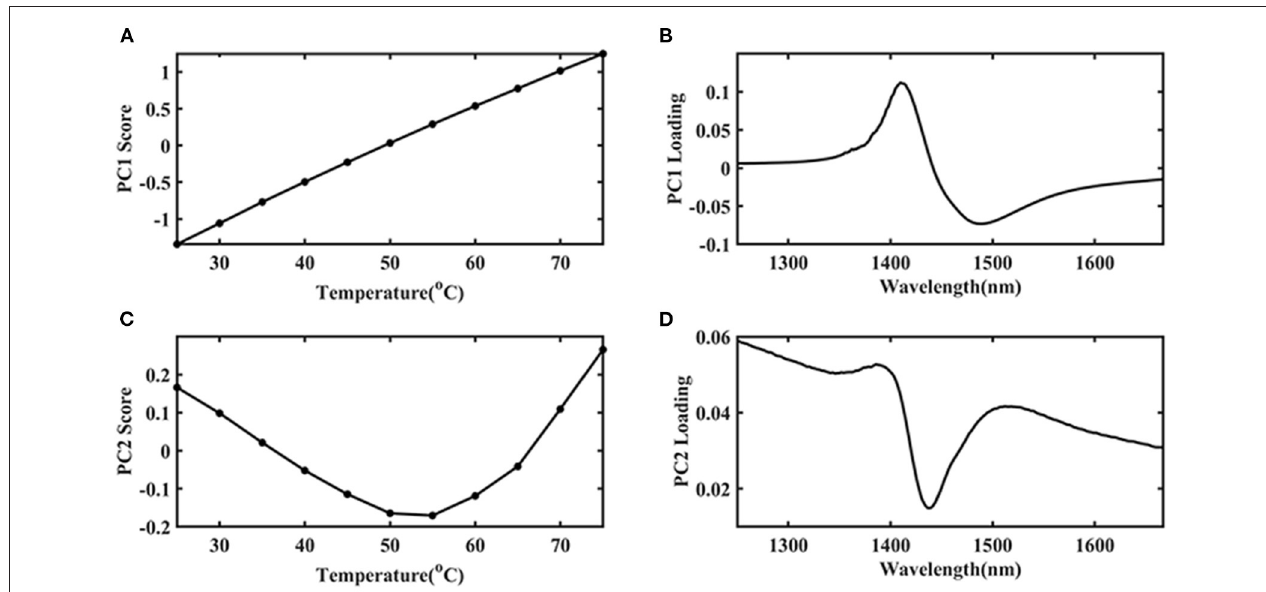
FIGURE 5 | The first principal component (PC 1) score plot of Ara h1 aqueous solution (A) and its loading plot (B) at different temperatures, the second principal component (PC 2) score plot of Ara h1 aqueous solution (C) , and its loading plot (D) at different temperatures. (1,250–1,667nm).